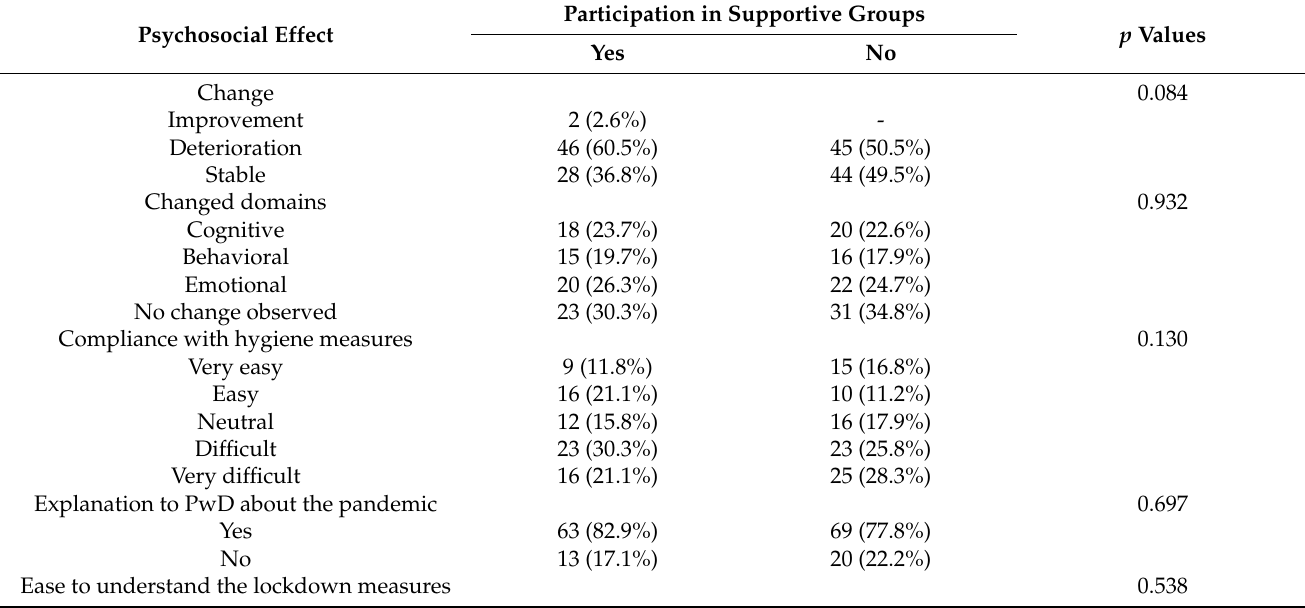
Table 9. Psychosocial effect of the quarantine in PwD—caregivers’